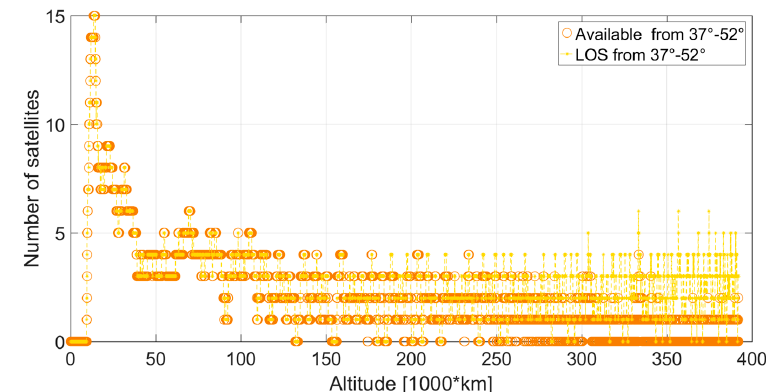
Figure 38. Visible satellites (in the line of sight (LOS)) and available satellites at the receiver’s position, for which the corresponding signal is transmitted at an angle between 30° and 37° from the transmitter’s boresight.